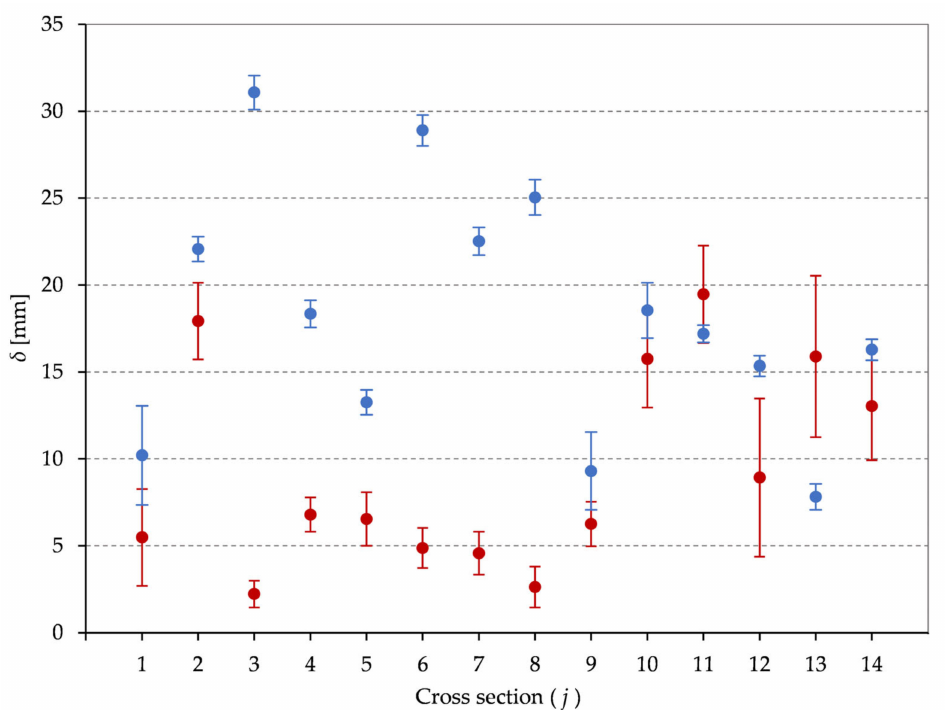
Figure 8. The differences between the semi-major and semi-minor ellipse axis for every cross section ( j ) with their standard deviations (error bars) for the TS-based data sets (red) and the UAS-based data sets (blue).